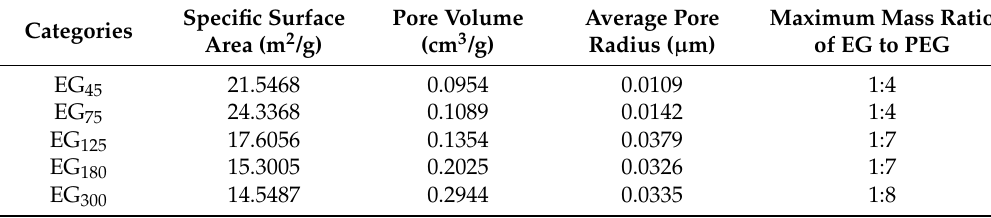
Table 3. Pore structure parameters of EGs with the maximum absorptive capacities.